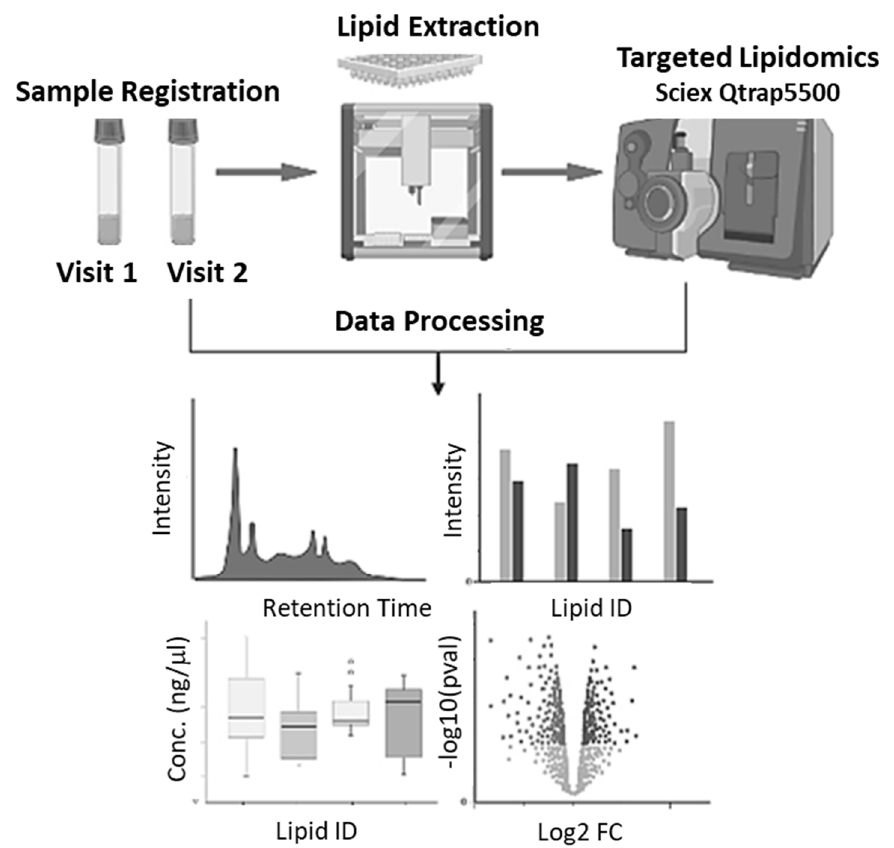
Figure 1. Targeted Lipidomics Workflow. Samples are registered and extracted using an automated sample extraction manifold. Extracted lipids are analyzed by LC/MS in a targeted manner to quantify DHA containing subset of lipids as well as low abundance oxylipins and endocannabinoids. Identified lipids are used to create profiles.